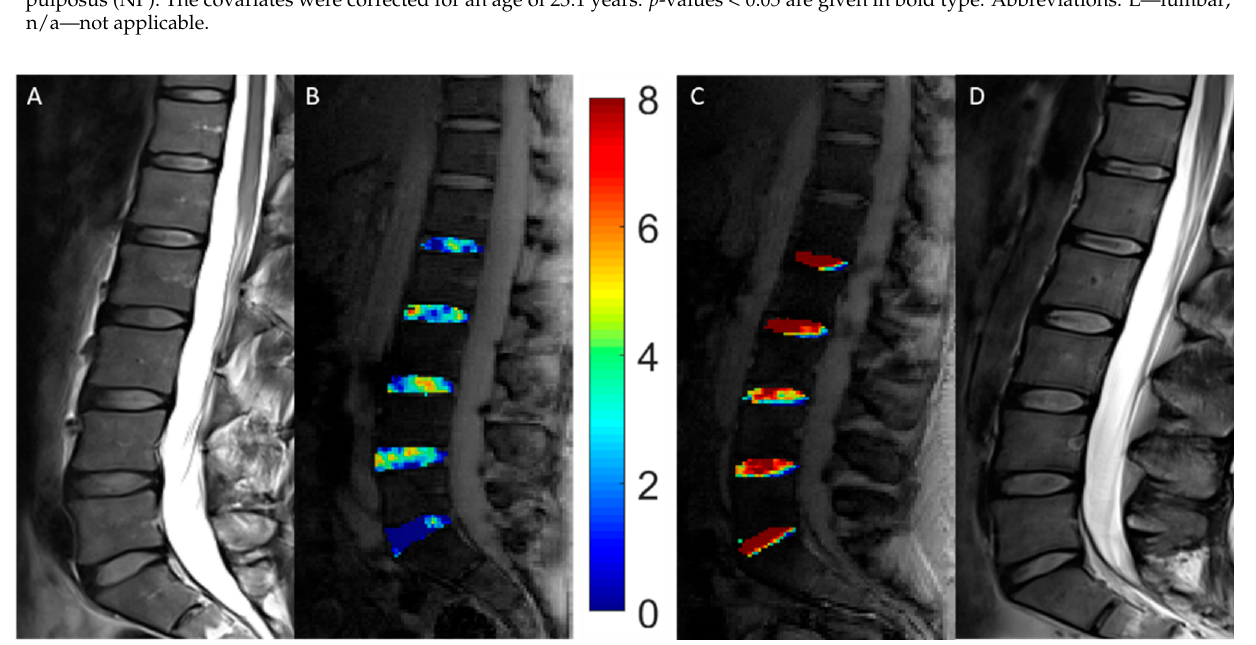
Figure 1. Representative morphologic and compositional imaging findings of the lumbar intervertebral discs (IVDs) of a patient with adolescent idiopathic scoliosis (AIS, A , B ) and a healthy control ( C , D ). ( A , D ): Sagittal T2-weighted images show the absence of morphologic signs of relevant intervertebral disc degeneration. ( B , C ): Sagittal gagCEST images with overlaid color-coded gagCEST maps to indicate the GAG content reveal distinct differences in GAG contents. Lower GAG content is indicated in blue, while high GAG content is illustrated in red. This patient with AIS demonstrated a lower GAG content than this healthy control despite non-degenerated IVDs in both individuals.